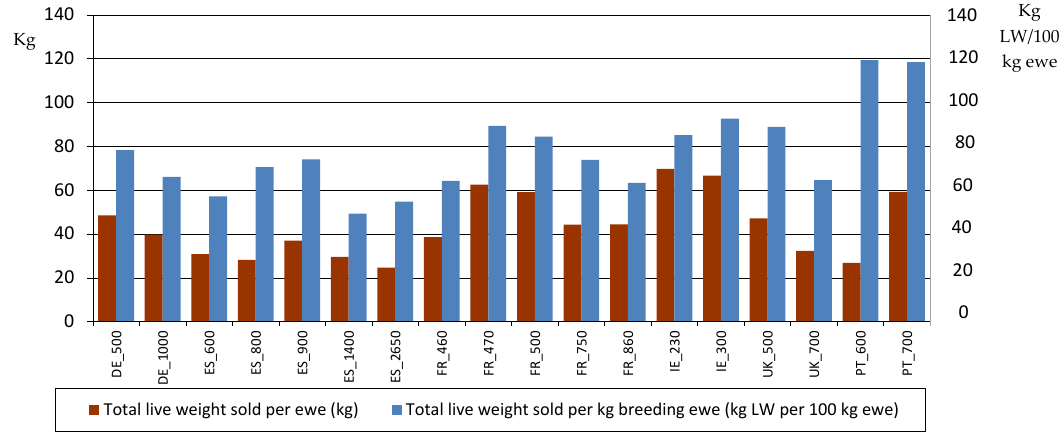
Figure7. TotalLWsold(perewe(kg)andperkgofbreedingewe(kgLW / 100kgewe). Figure 7. Total LW sold (per ewe (kg) and per kg of breeding ewe (kg LW/100 kg ewe). Source: model results.